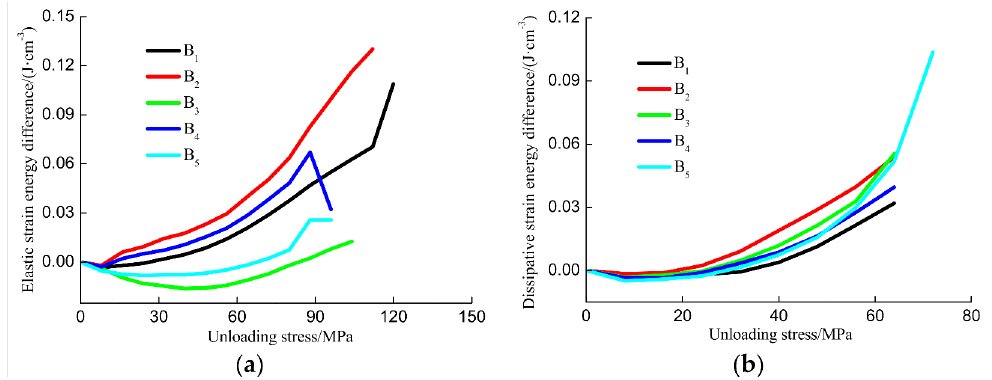
Figure 12. Strain energy difference of saturated rock samples. ( a ) Elastic strain energy difference. ( b ) Dissipative strain energy